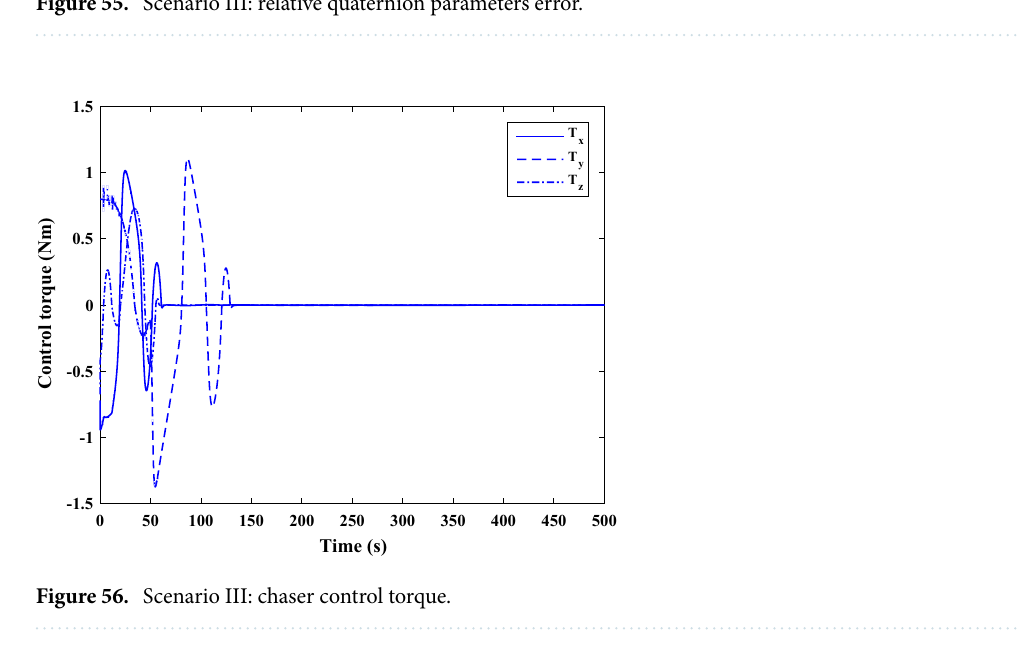
Figure 55. Scenario III: relative quaternion parameters error.